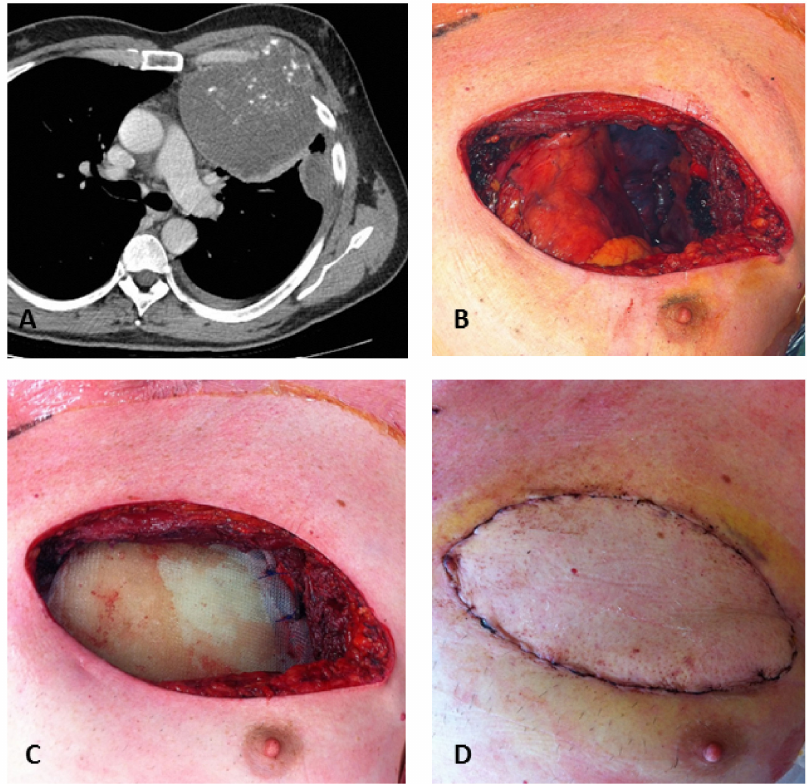
Figure 5. A 67-year-old male patient with a high-grade chondrosarcoma of the costochondral junction. Axial contrast-enhanced CT image ( A ) shows a large chondrosarcoma of the left costochondral junction with less than 25% calcified matrix and a large soft tissue mass. Little left pleural effusion is also present. Intraoperative views show radical resection ( B ), reconstruction by composite rigid prosthesis ( C ), and latissimus dorsi flap reconstruction ( D ). Courtesy of Prof Francesco Petrella, Istituto Europeo di Oncologia (IEO), Milan,